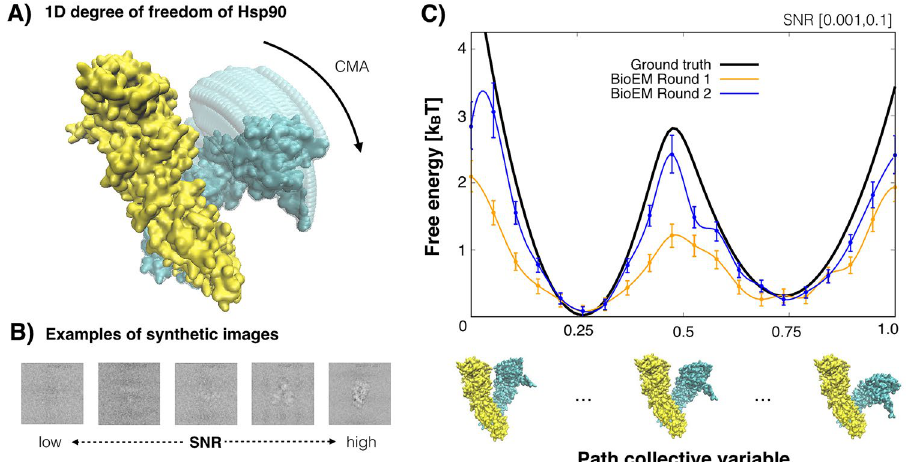
Figure 2. 1D analysis of Hsp90. ( A ) Movement of Hsp90 along the single degree of freedom (CMA). The rotation of chain A relative to a fixed chain B. ( B ) Examples of the synthetic images with varying SNR between [0.001, 0.1]. ( C ) Free-energy profiles along the path for the entire set of images recovered from cryo-BIFE. The ground truth free-energy profile is shown in black. The expected free energy profile using cryo-BIFE is shown for BioEM orientation rounds 1 and 2 in orange and blue, respectively. The R-hat test for the MCMC stationarity yielded 1.000 and 1.001 for BioEM round 1 and 2, respectively. The bars show the credible interval at 5% and 95% of the empirical quantile at each node. A cubic spline is used to fit the expected free-energy profile, providing a smooth profile.